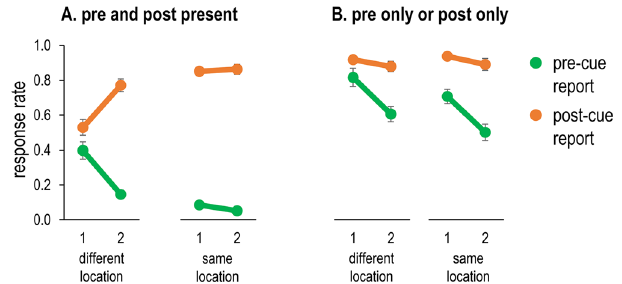
Figure 6. Frequency of pre-cue digit reports (green lines) and post-cue digit reports (orange lines) in Experiment 2, for trials with two digits adjacent to the selection cue (A) and trials where only a pre-cue or post- cue digit was present (B), as a function of the number and the number of streams (1 vs. 2), and the location of the pre- and post-cue items (same vs. different). Error bars denote one standard